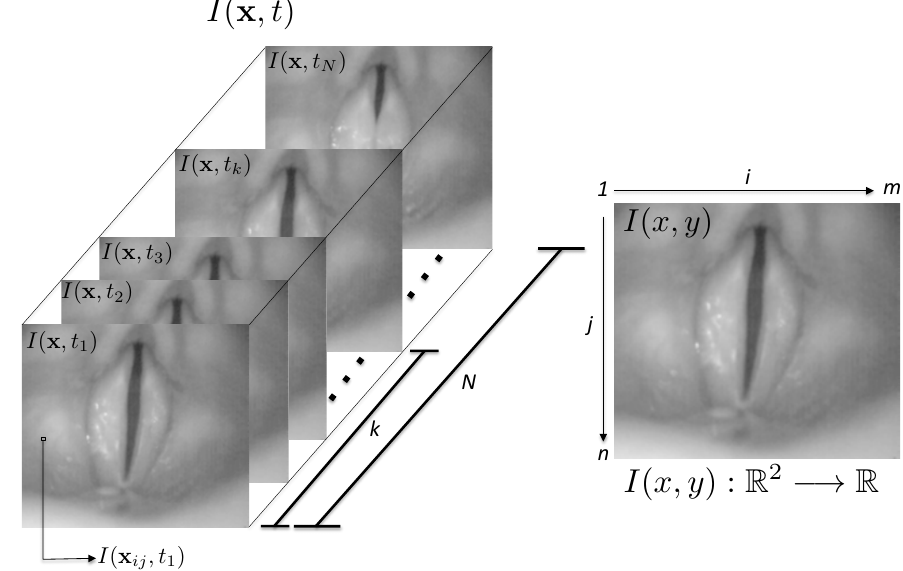
Figure 5. Laryngeal image sequence with its respective notation. ( Left side ) laryngeal image sequence I ( x , t ) ; ( right side ) single image I ( x , y )